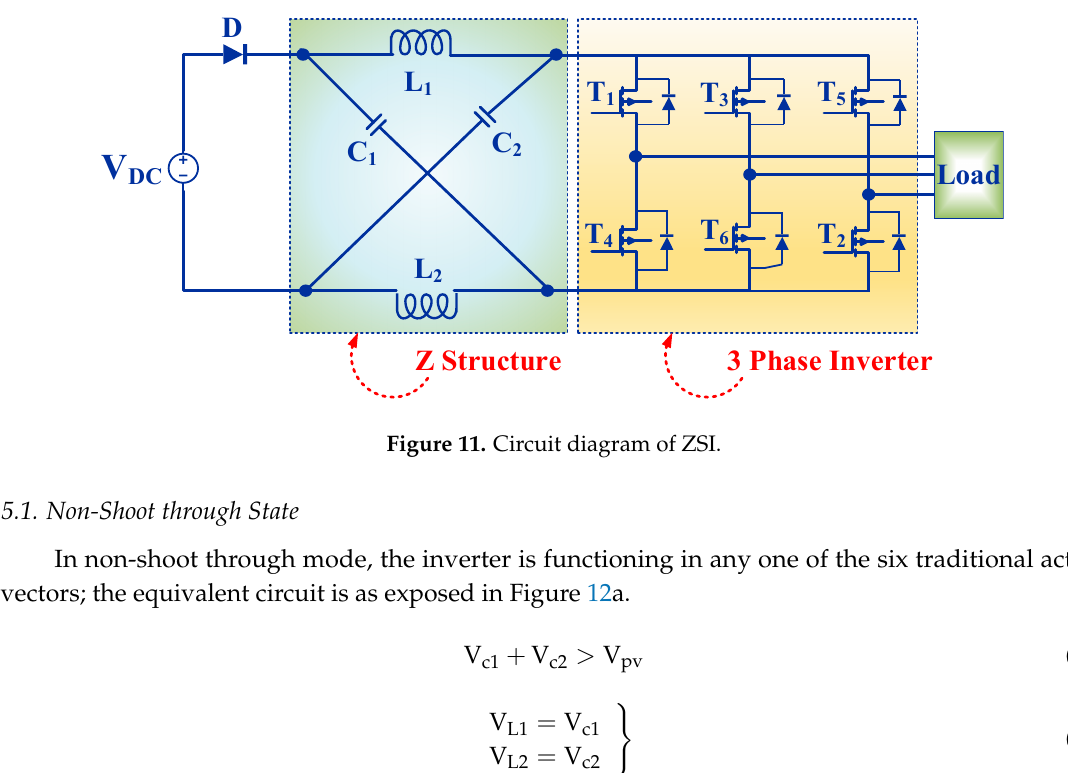
Figure 12. Equivalent Circuit of the ZSI in ( a ) Non-Shoot through States; and, ( b ) Shoot-Through State.